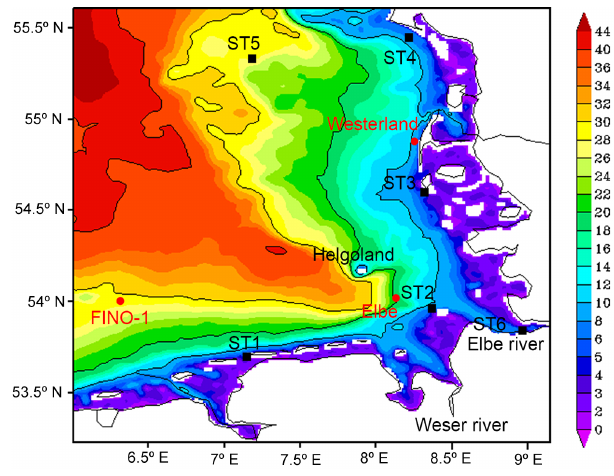
Figure 1. German Bight bathymetry (contour lines correspond to isobaths 10, 20, 30 and 40m). The geographical location of stations analysed later are shown as well. The wave data stations are plotted in red circles and the stations in which we analyse the sea level variability (ST1-6) are plotted in black squares.